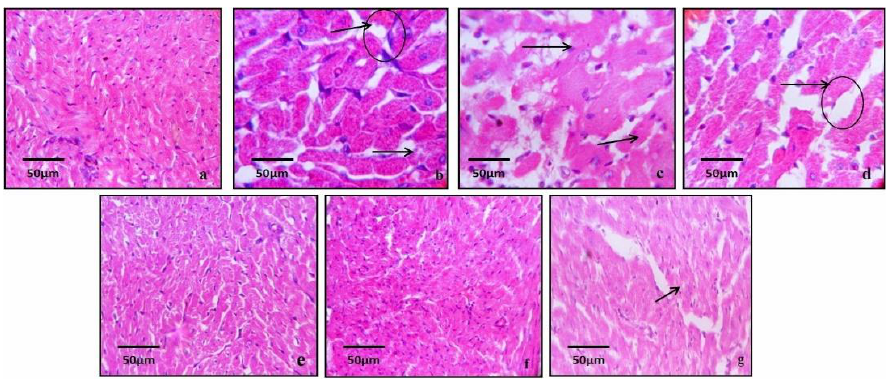
Figure 10. Histopathology of cardiac tissues from different treatment groups. Where, ( a ). Normal Control; ( b ). is D-HFD-C; ( c ). Olive Oil-C; ( d ). PHC-6 treated; ( e ). PHC10 treated; ( f ). Metformin treated; ( g ). Carvedilol treated.